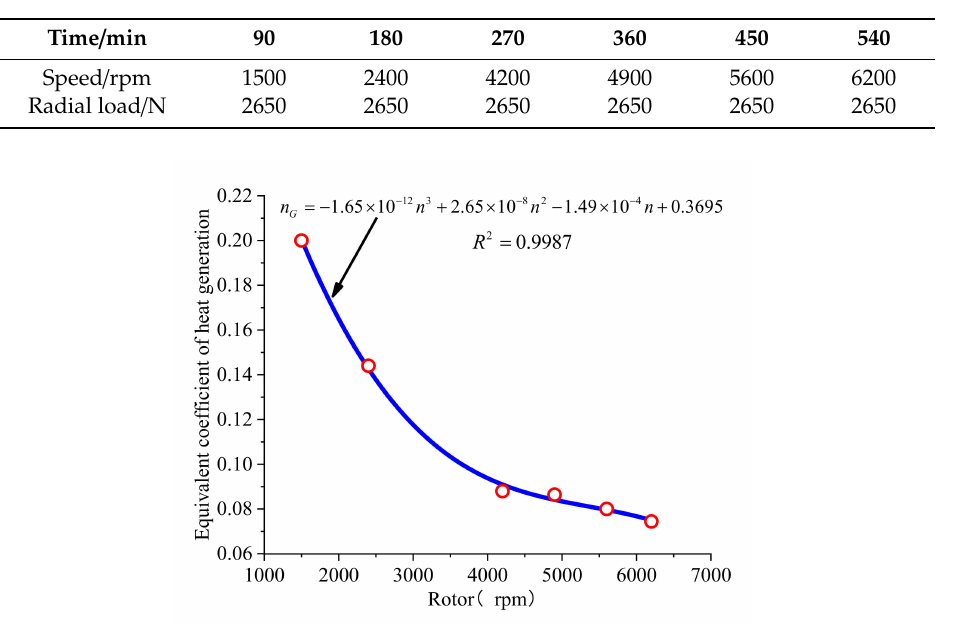
Table 5. Bearing temperature rise experiment condition.